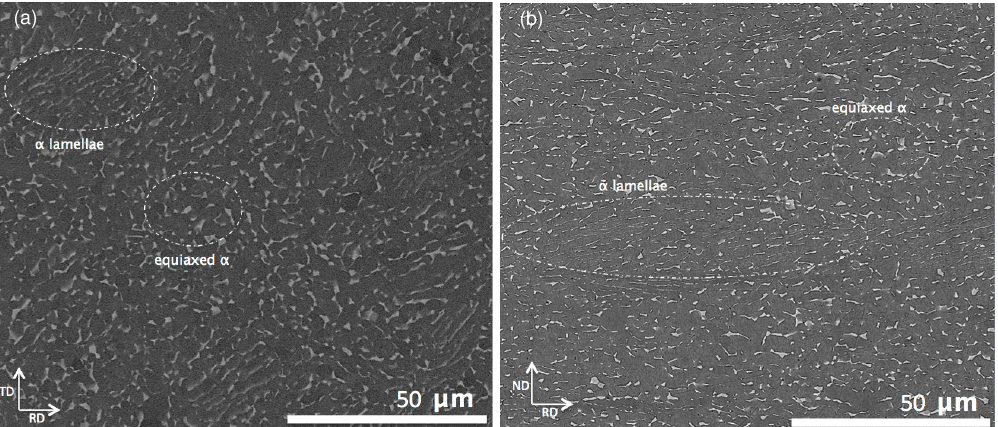
Figure 3. SEM images of the initial microstructure revealing co-existence of equiaxed α nodules and elongated α lamellae ( a ) RD-TD surface and ( b ) RD-ND surface.the dark phase is α and the lighter phase is β